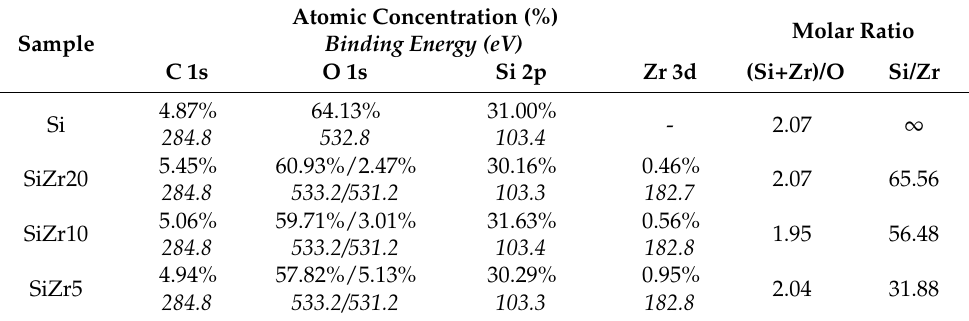
Table 2. Spectral parameters, estimated by XPS, of the porous